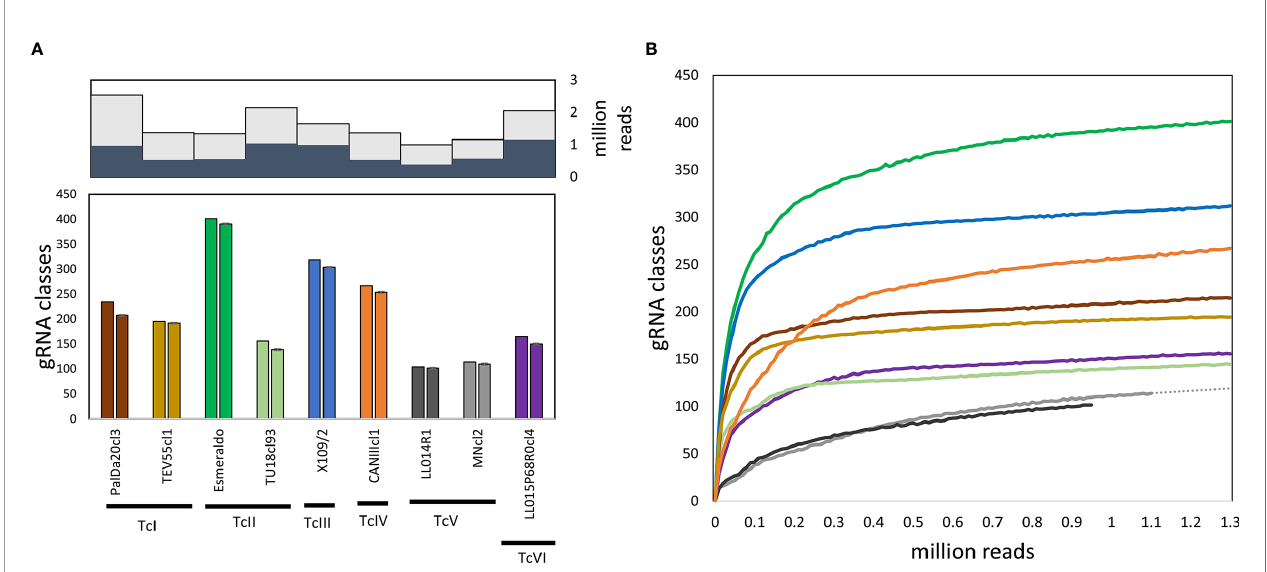
FIGURE 1 | Variable gRNA diversity among strains. (A) Top, mHVR sequences with gRNA hits (dark grey) related to the number of analyzed mHVR sequences (light gray); bottom, number of gRNA classes (>20 reads) using a SWARM-like algorithm and detected for each strain (left column for each strain) and the average number of gRNA classes after down-sampling one-hundred times the number of paired-end reads to 950,000 (right column for each strain) with standard deviation bars. (B) Rarefaction curves for the number of gRNA classes (>20 reads) for each strain (solid lines, the color reference is according to (A) . Dotted line is an extrapolation for MNcl2 based on a linear regression using last ten samples showing that increasing the sequencing depth will not signi fi cantly increase the number of detected gRNA